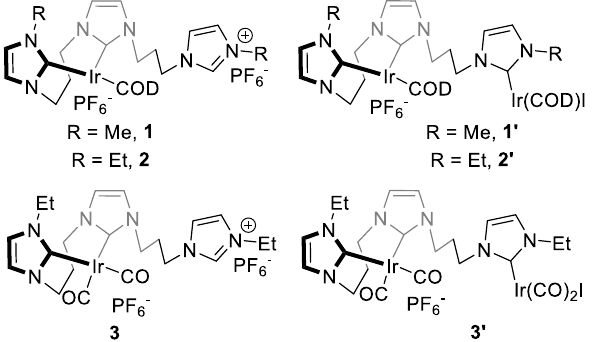
Figure 1. Ir catalysts for the transfer hydrogenation of CO 2 and carbonates with glycerol.